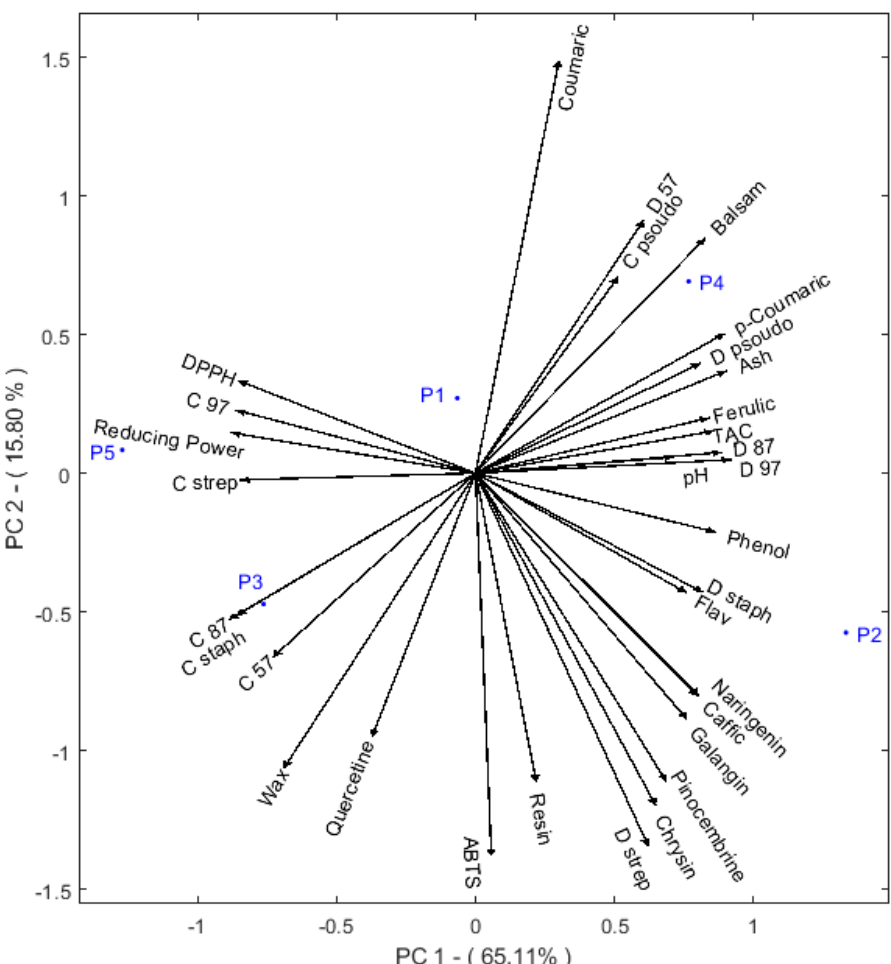
Figure 2. Principal component analysis (PCA) of the analyzed propolis samples using the assessed parameters as an input. Wax; resin; balsam; ash; pH; phenol: total phenolic; flav: flavone and flavonol; TAA: total antioxidant capacity; DPPH: 2,2-